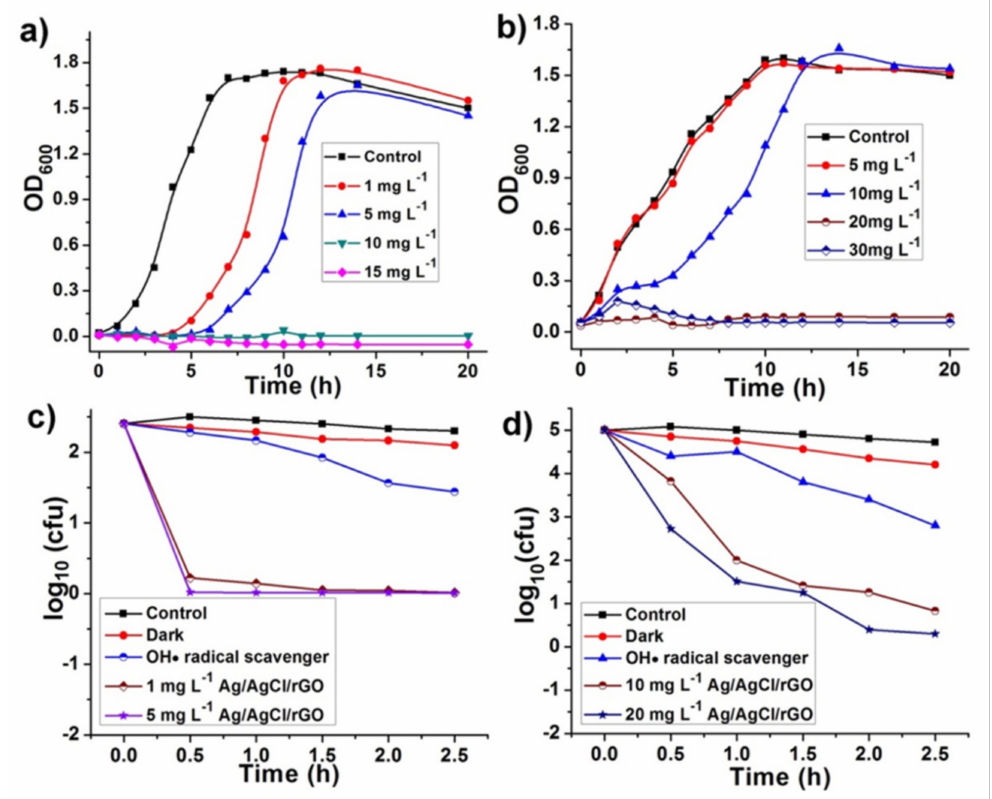
Figure 5. Growth profile in LB medium with serial concentrations of Ag/AgCl/rGO nanomaterial added to the culture of ( a ) E. coli and ( b ) S. aureus . Bacteria time–kill profiles within 2.5 h for ( c ) E. coli in the presence of 1 or 5 mg L − 1 Ag/AgCl/rGO nanomaterial and ( d ) S. aureus in the presence of 10 or 20 mg L − 1 Ag/AgCl/rGO nanomaterial. The bacteria time − kill profiles of E. coli ( c ) and S. aureus ( d ) treated with Ag/AgCl/rGO were also performed in a dark environment or with the OH* radical scavenger (adapted with permission from reference